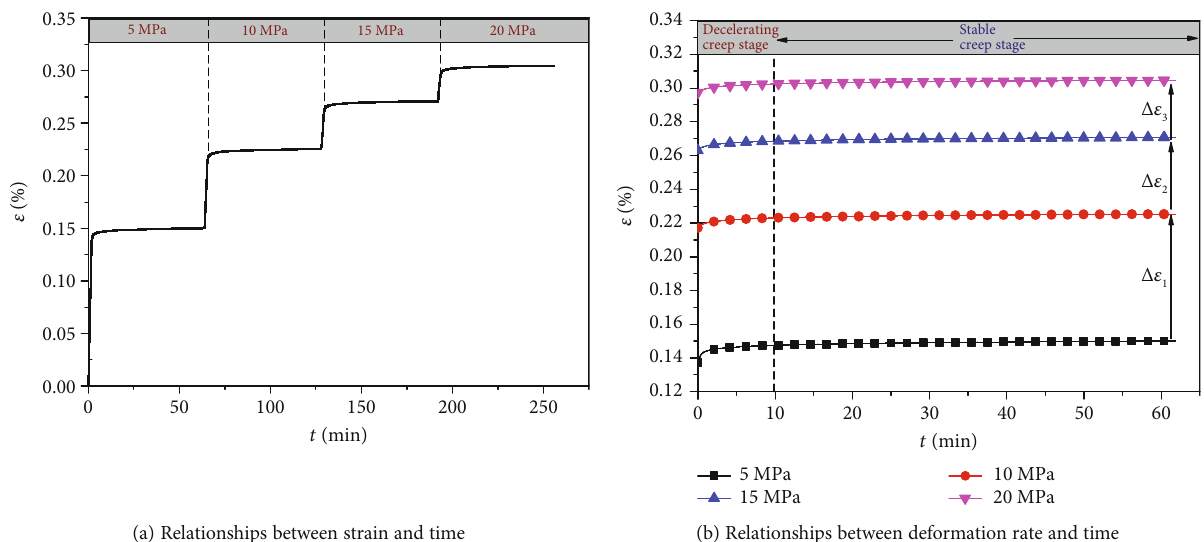
Figure 2: Gangue creep